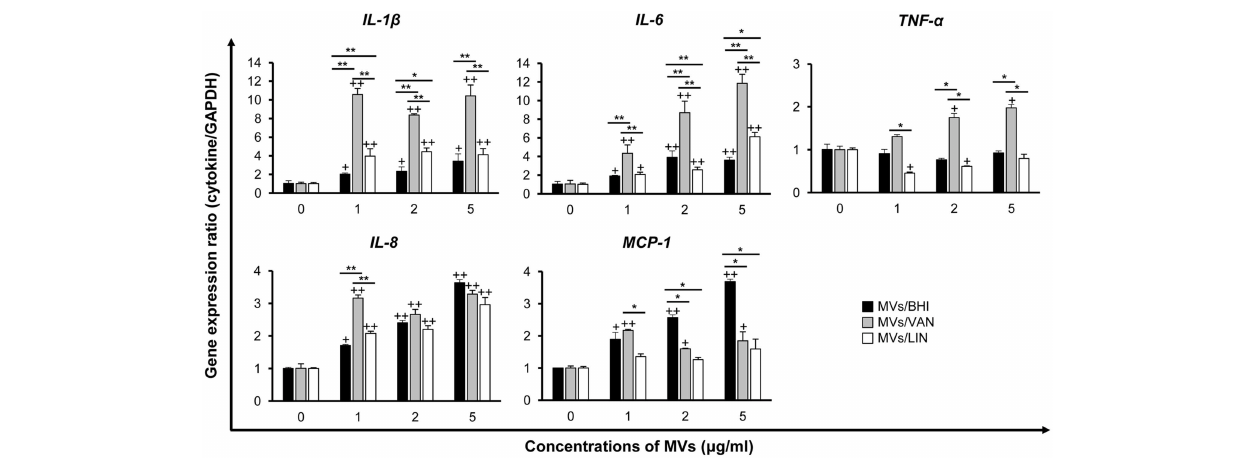
FIGURE 4 | Expression of pro-inflammatory cytokine and chemokine genes in Caco-2 cells treated with MVs from E. faecium ATCC 700221. MVs were isolated from culture supernatants of E. faecium cultured in BHI broth (MVs/BHI), BHI broth with 256 µ g/ml vancomycin (MVs/VAN), or BHI broth with 1 µ g/ml linezolid (MVs/LIN). Cells were treated with various concentrations of E. faecium MVs for 3h and gene expression was assessed via qPCR. Data are presented as the mean ± SD of three independent experiments. + P < 0.05, ++ P < 0.01 compared to untreated control cells. * P < 0.05, ** P < 0.01 among the same concentrations of MVs/BHI, MVs/VAN, or MVs/LIN.